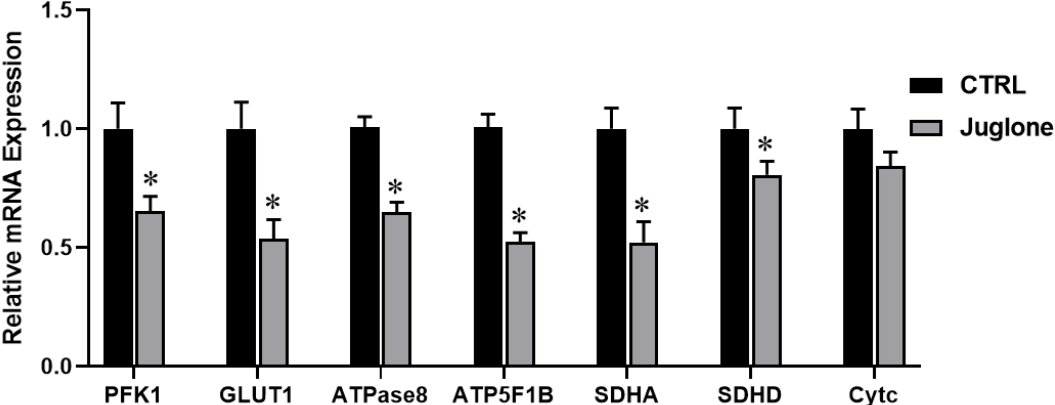
Figure 5. The relative expression of metabolic pathways in oocytes using glucose metabolism-, ATP synthesis-, and OXPHOS-related genes tested using RT-qPCR (three replicate; n = 50). Bovine oocytes were incubated with 25 µ M of juglone during in vitro maturation (IVM). Columns with an asterisk (*) indicate statistical significance.